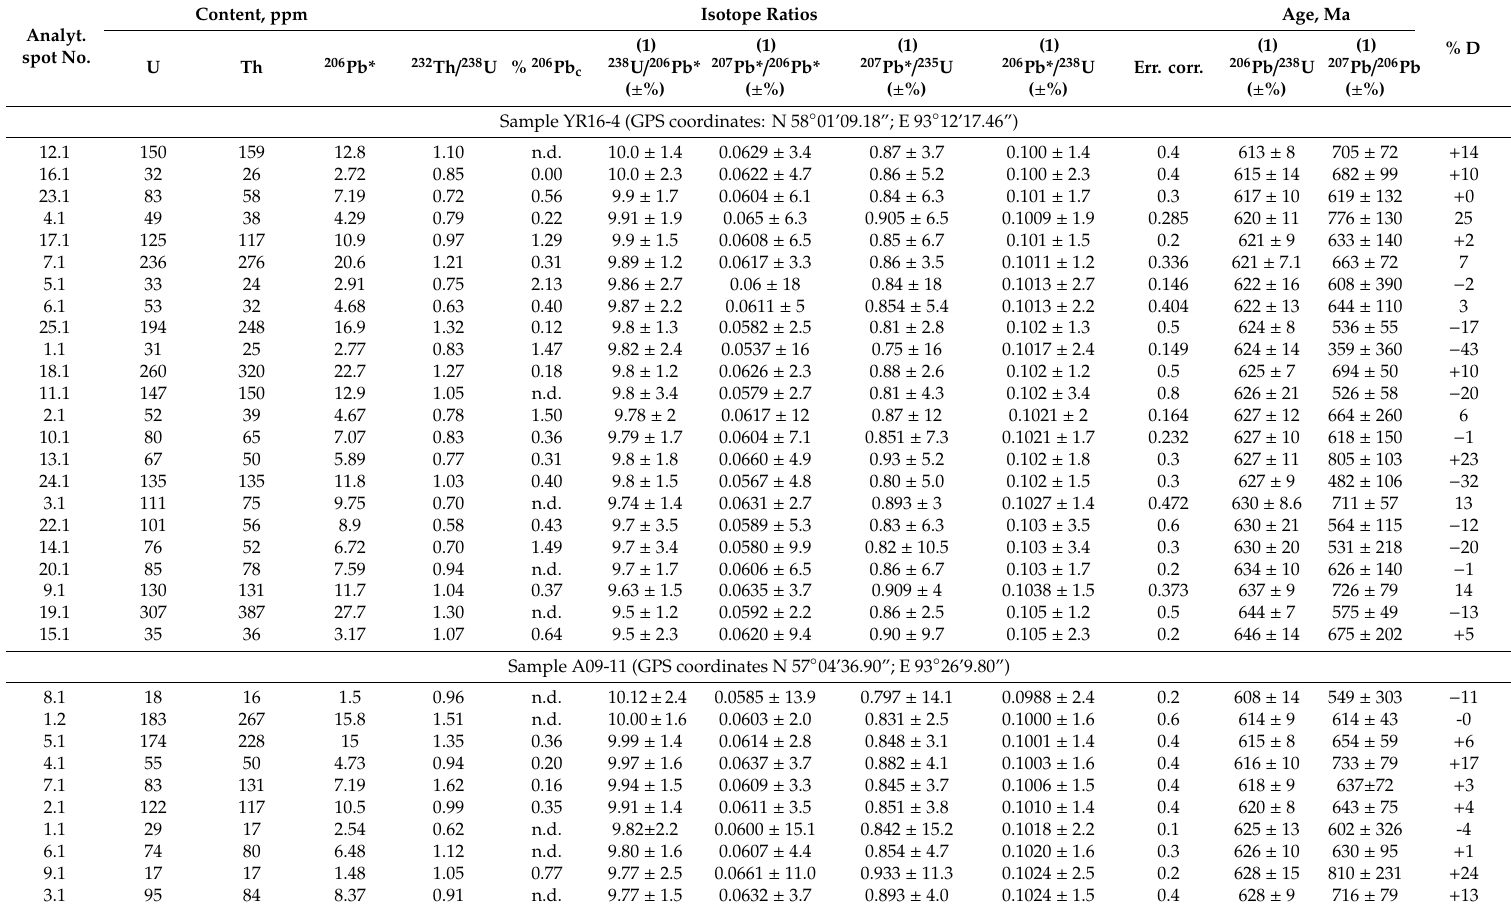
Table 2. Results of U-Th-Pb isotope